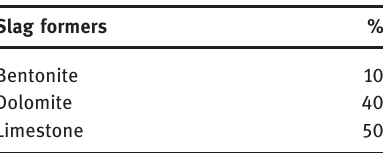
Table 2: The contents of slag formers used in the study (%).